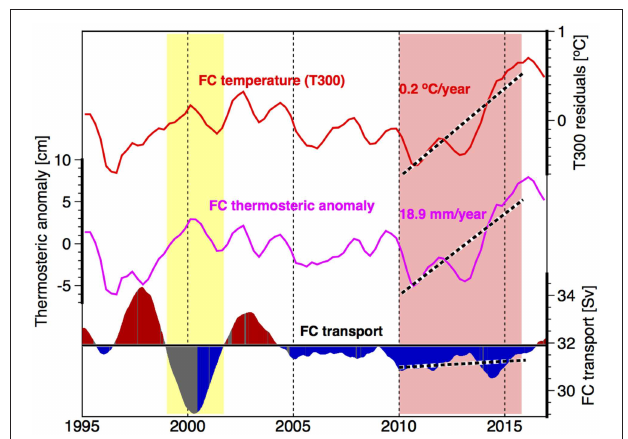
FIGURE 11 | Time-series of the average temperature residuals (seasonal cycle removed) for the upper 300m of the water column in the Florida Straits (red, T300), of thermosteric anomalies derived from the temperature data observed in the Florida Straits (magenta), and of the Florida Current (FC) volume transport (red and blue filled curve) measured in the Florida Straits using telephone cable voltage differences, and complemented using satellite altimetry data (gray). All time series are displayed after applying a 1-year low pass